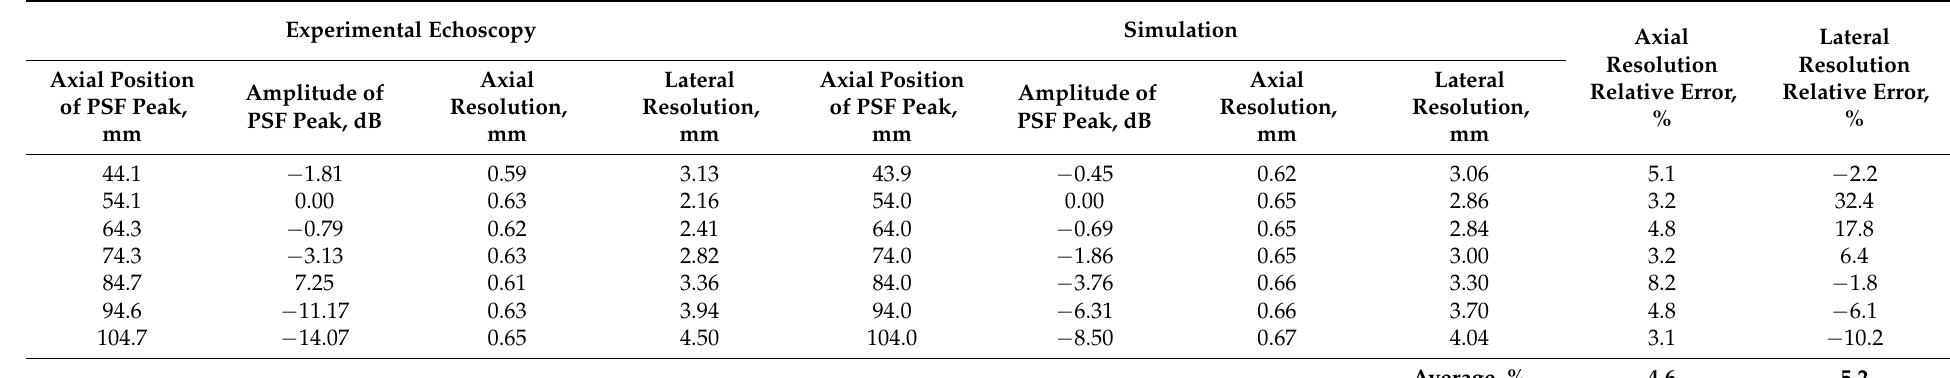
Table 3. FWHM parameter comparison of experimental echoscopy of physical wire phantom and simulation of wire phantom by point scatterers. Experimental